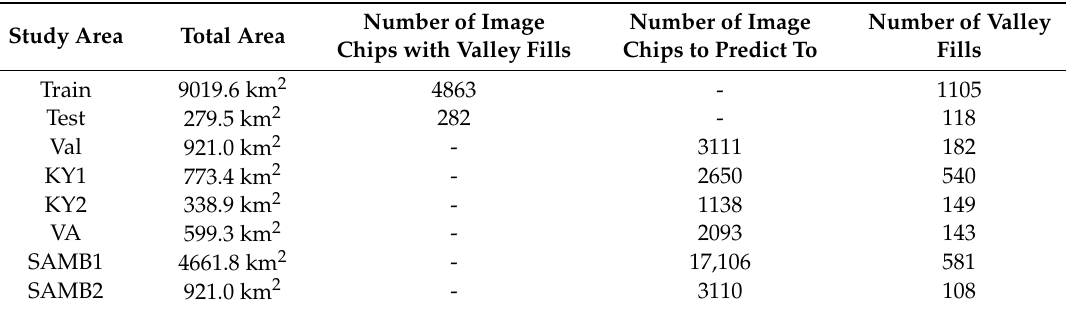
Table 1. Description of study areas and mapped